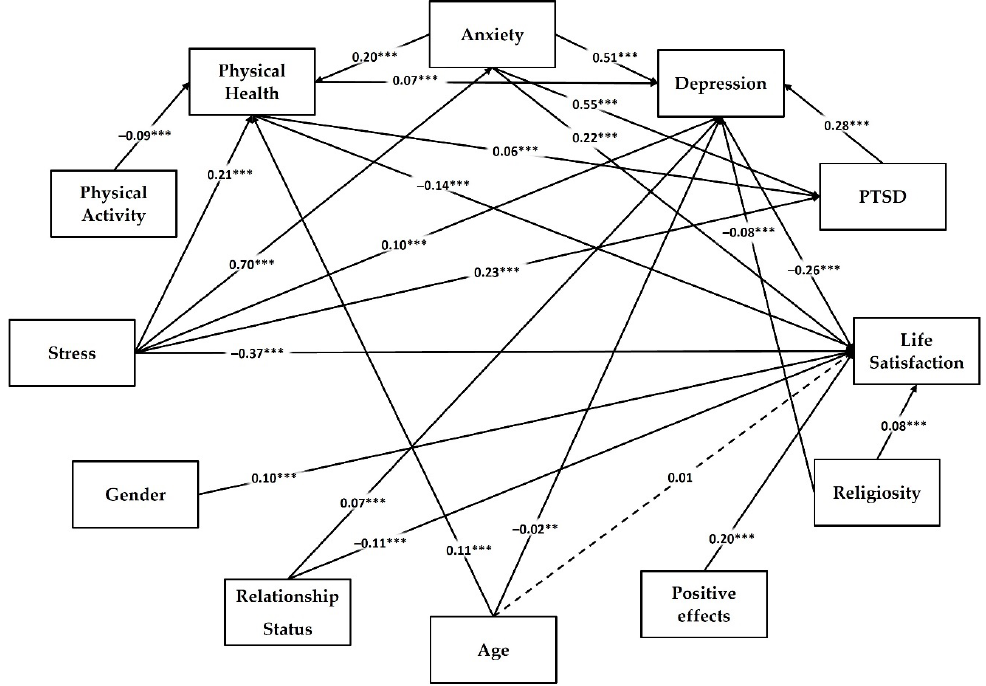
Figure 2. Path model with standardized regression weights for predictors of well-being among university students during the second wave of the COVID-19 pandemic ( n = 3230); ** p < 0.01; *** p < 0.001. Table 8. Estimation of path parameters for life satisfaction ( N = 3230).